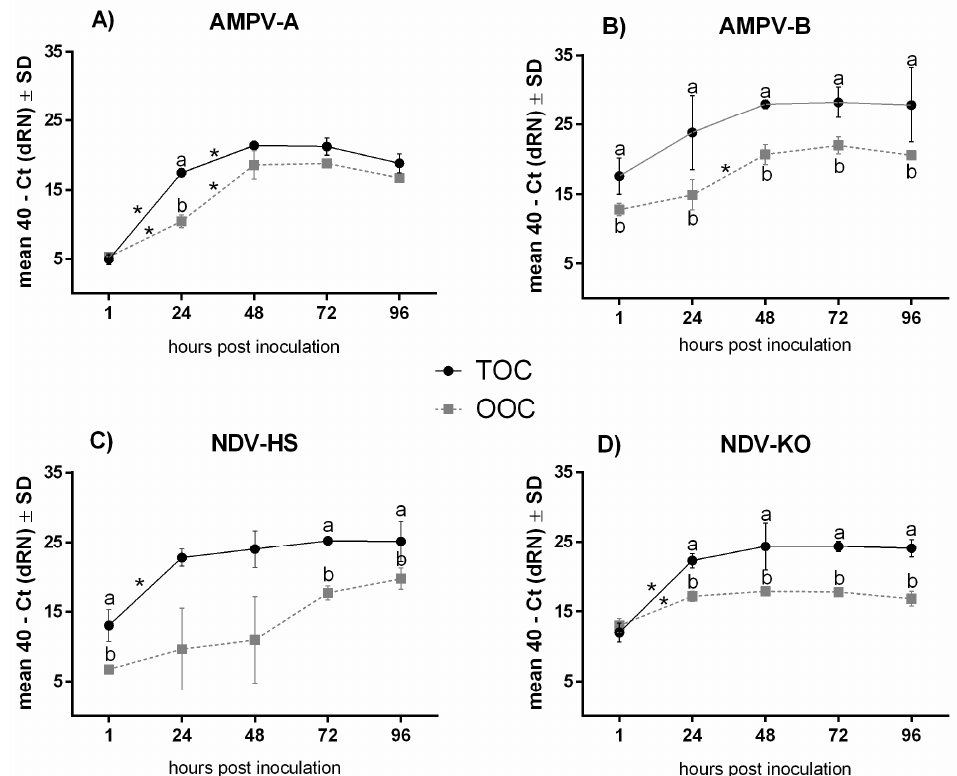
Figure 1. Comparative quantification of viral genome using qRT-PCR in TOCs and OOCs after inoculation with AMPV-A ( A ), AMPV-B ( B ), NDV-HS ( C ), or NDV-KO ( D ). For each group, three to five rings were collected at 1, 24, 48, 72, and 96 hpi and processed for viral quantification. Normalised data are presented as mean 40 - Ct. Error bars represent standard deviations (SD). * indicates significant differences between different inoculation time points for each virus, determined using the Tukey HSD all-pairwise comparison test. Small letters indicate significant differences between TOCs and OOCs at the same time point for each virus, determined using two-sample t -tests. p -value < 0.05. Graphs represent data from one representative experiment.